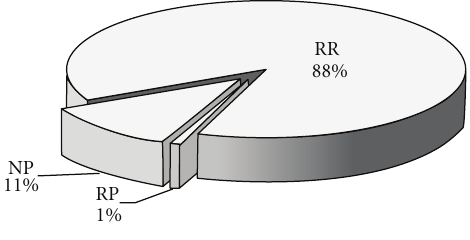
Figure 5: Emergy input ratio of